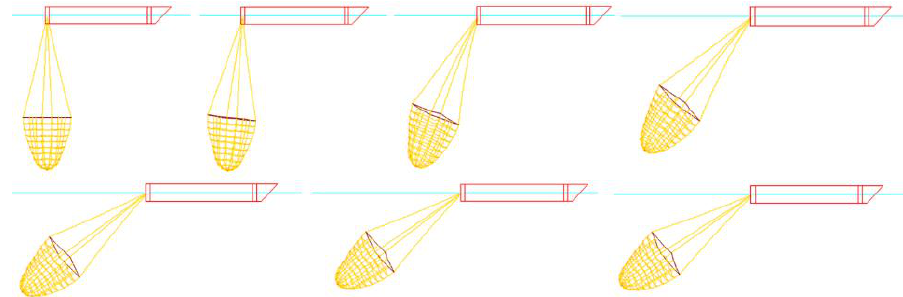
Figure 14. Shape changes of rigid truss trawl in straight-line towing at v = 2 m/s.